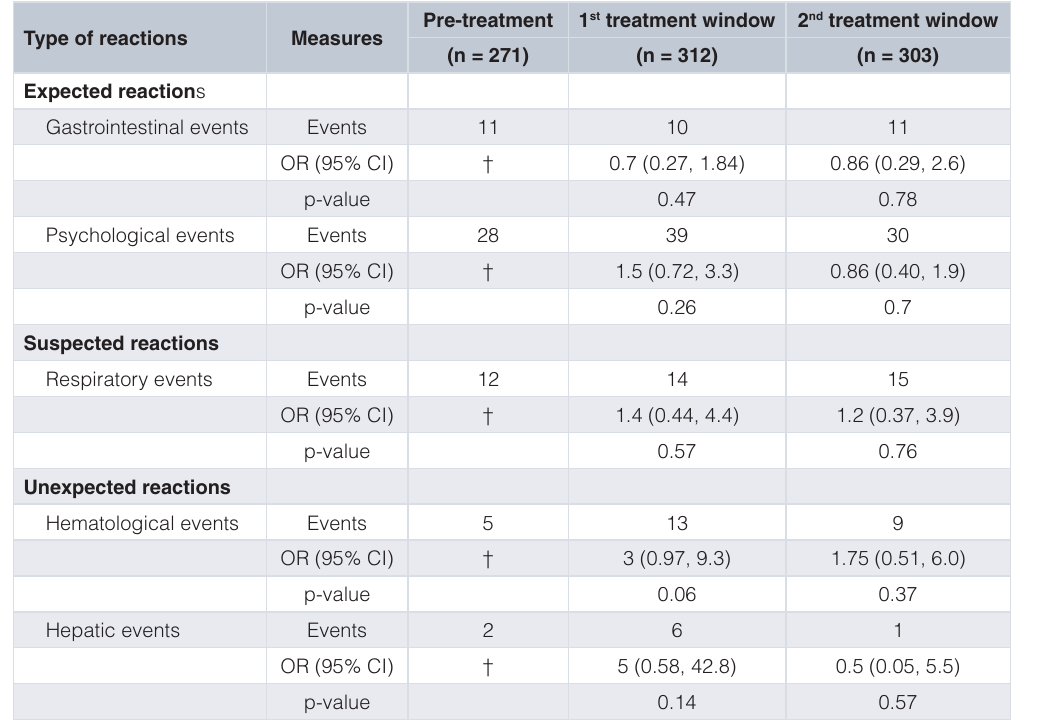
Table 6. Cohort crossover design: evaluation of acute and transient effects of AChEI